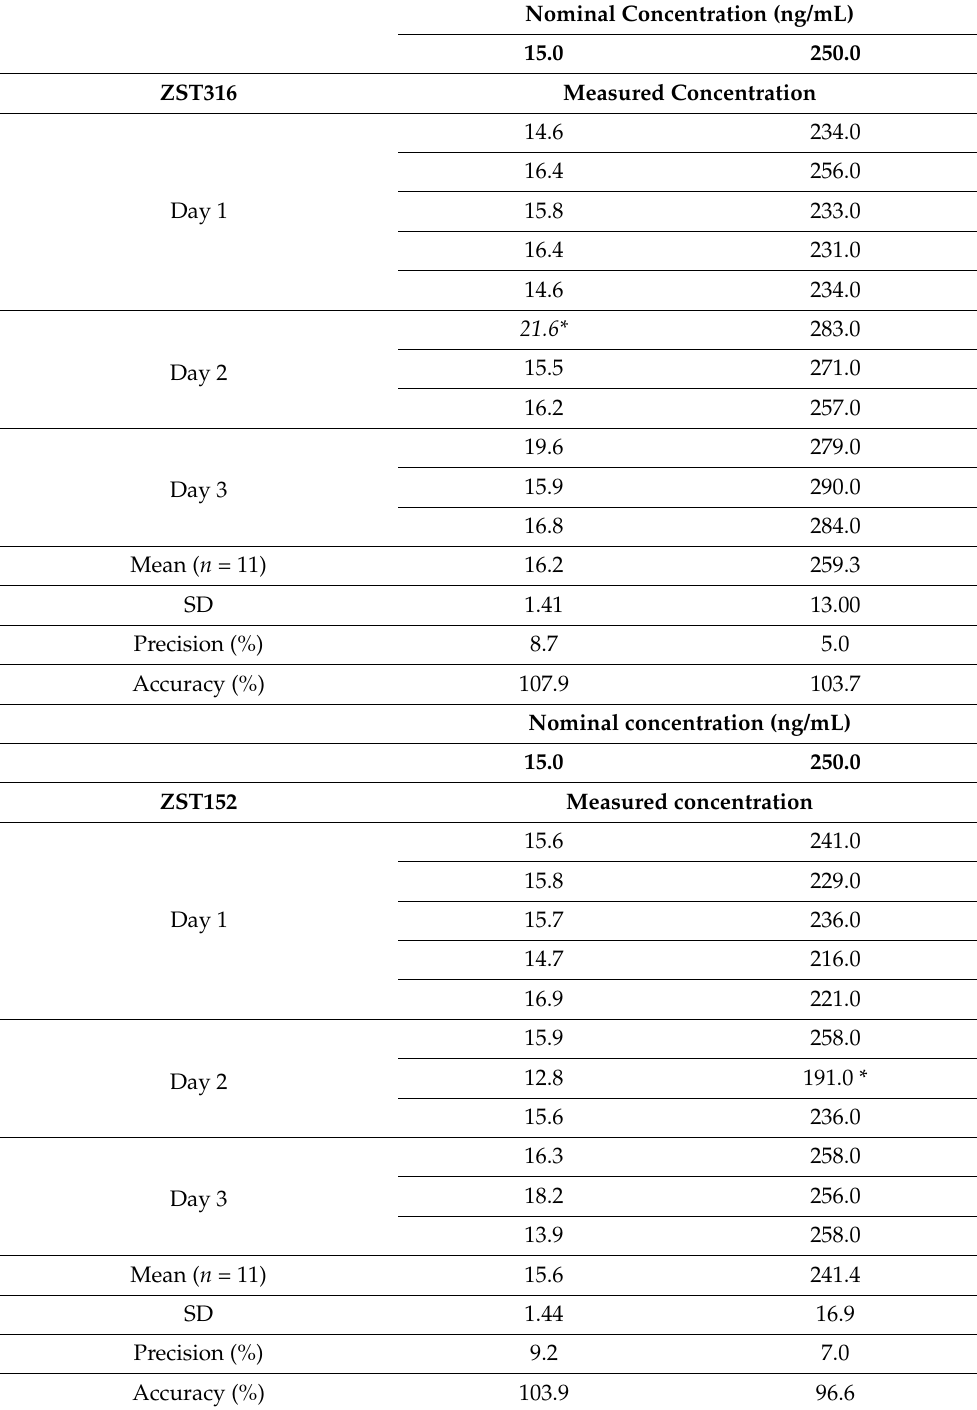
Table 3. Inter-day precision and accuracy results for ZST316 and ZST152 in